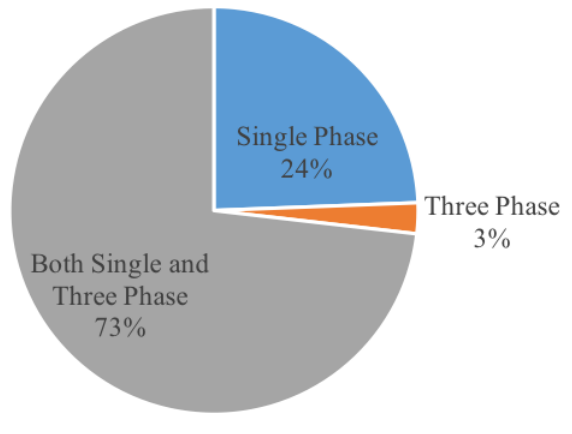
Figure 3. E-monitor utilization